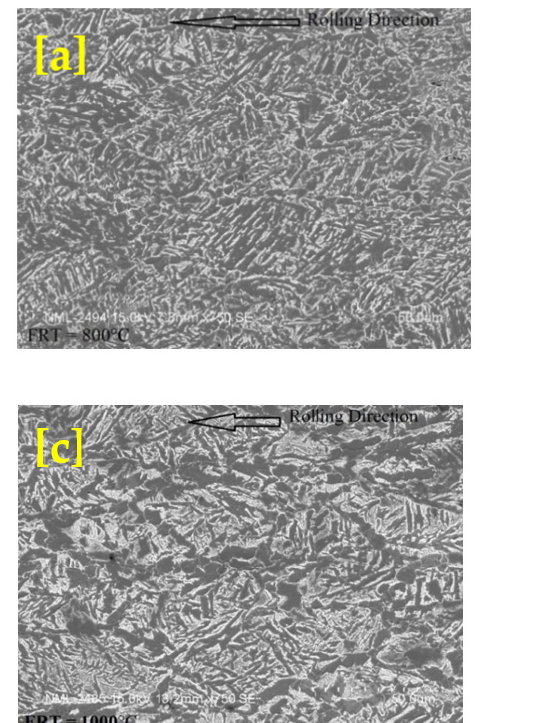
Figure 9. Scanning electron micrographs of rolled niobium microalloyed steel which finishing rolling temperature ( a ) 800; ( b ) 900; ( c ) 1000 °C.